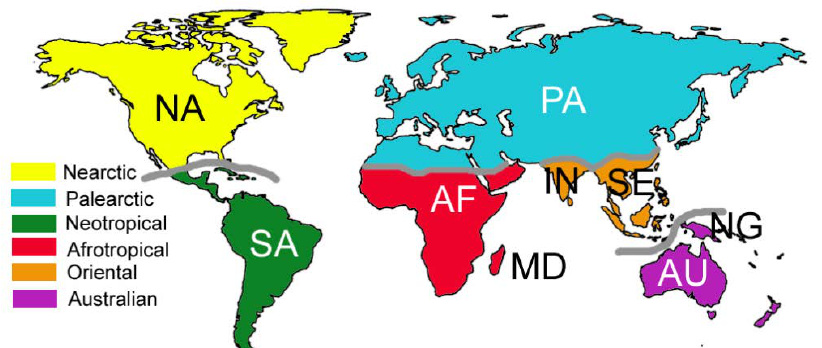
Figure 1. Zoogeographical regions and areas of endemism used in this study. Areas of endemism: AF = Arica (south of the Sahara), AU = Australia, IN = India, MD = Madagascar, NA: North America, NG = New Guinea, PA= Palearctic, SA = South America, SE = South East Asia.